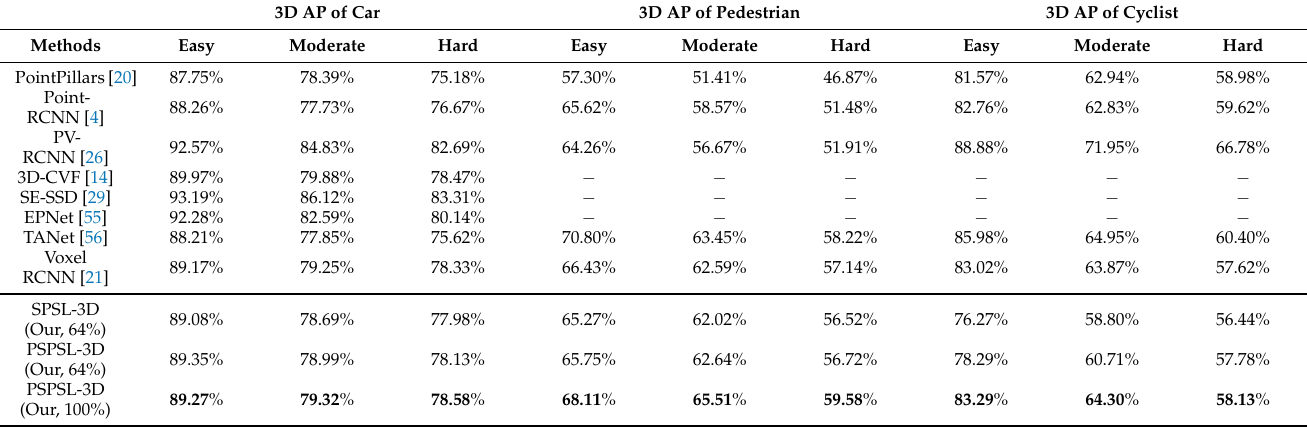
Table 6. 3D AP of the proposed SSOD-3D at R anno = 64% and current FSOD-3D methods in KITTI validation